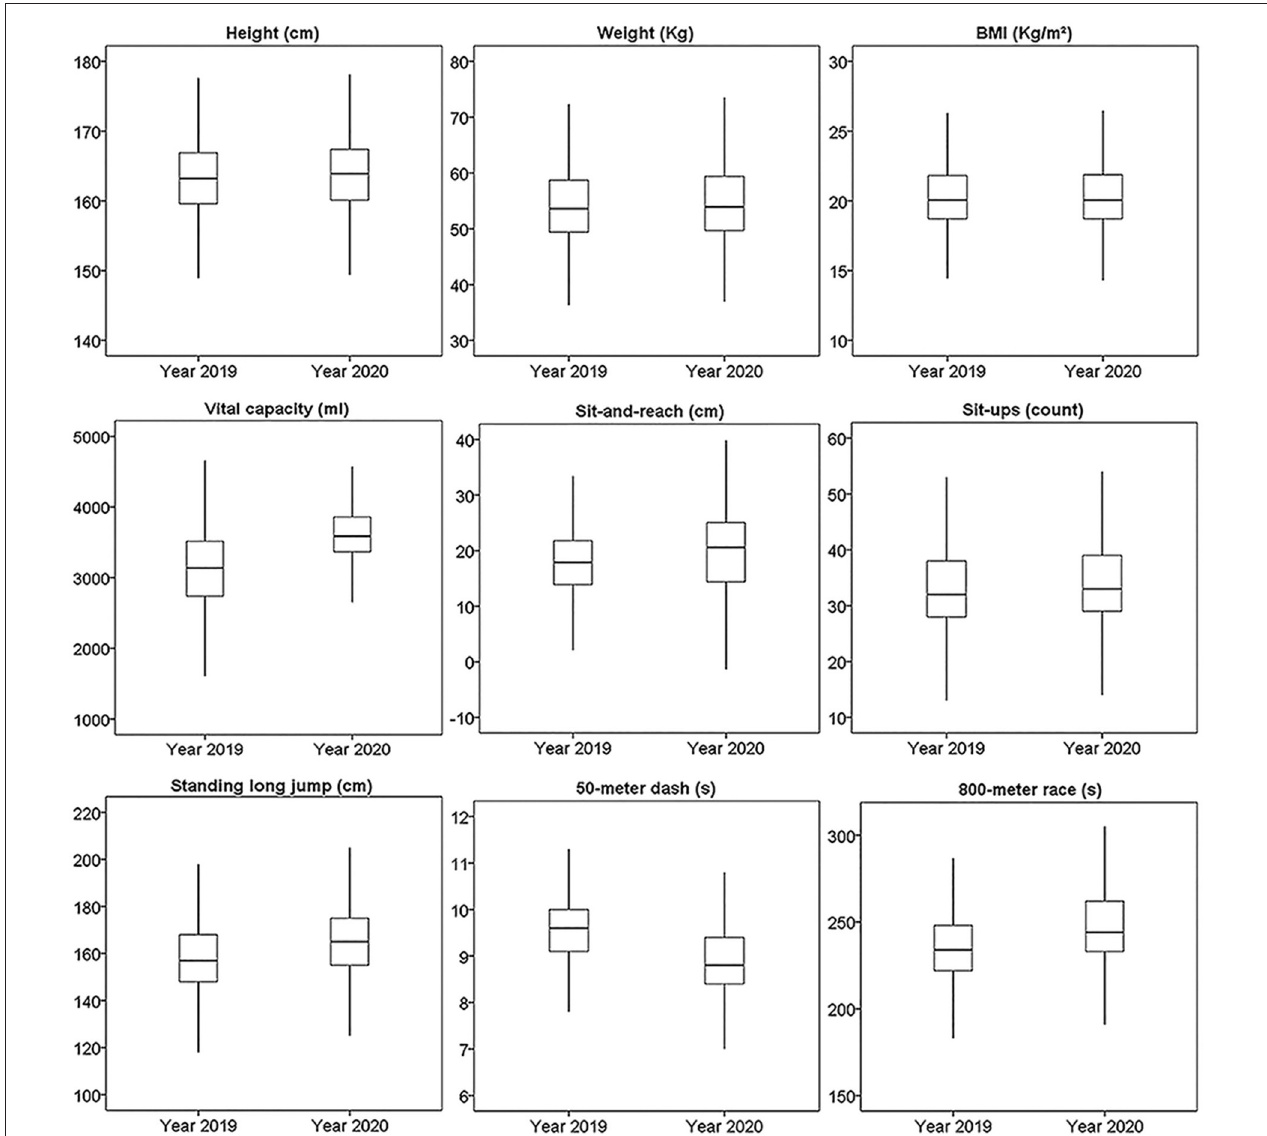
FIGURE 3 | The boxplots of nine results of physical fitness tests from 9,690 female records. Middle line in the box represents the median. The upper and lower boundaries of the box represent upper and lower quartiles. The endpoints of whiskers represent upper and lower extremes. different between 2019 and 2020 ( p = 0.001 for weight; p < 0.001 for height, vital capacity, 50-m dash, sit-and-reach, sit-ups, standing long jump, and 800-m